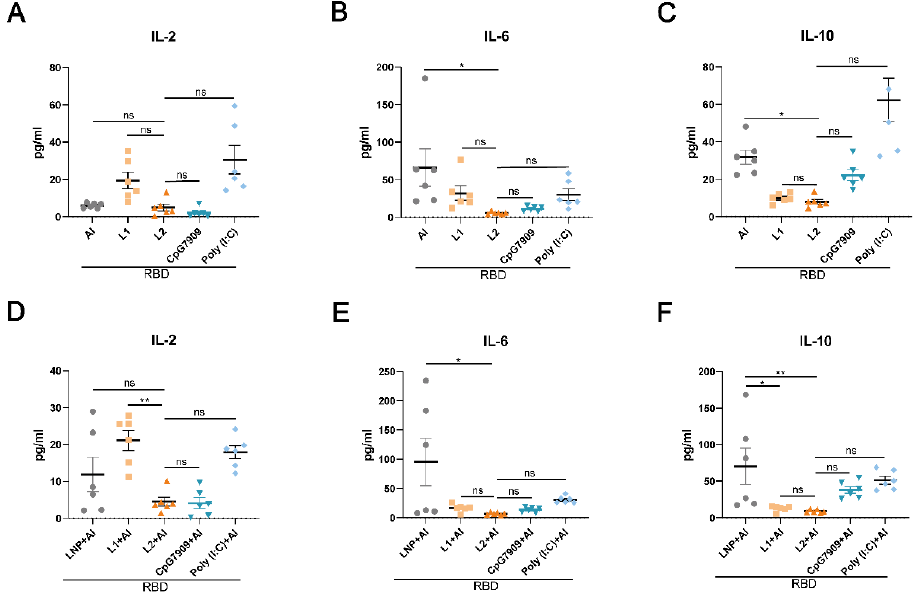
Figure Appendix A2. Levels of IL-2, IL-6, and IL-10 secreted by splenocytes in mice. ( A – C ) Levels of IL-2, IL-6, and IL-10 secreted by splenocytes in RBD + Al, RBD + L1, RBD + L2, RBD + CpG7909, and RBD + Poly(I:C). ( A ) IL-2. ( B ) IL-6. ( C ) IL-10. ( D – F ) Levels of IL-2, IL-6 and IL-10 secreted by splenocytes in RBD + LNP + Al, RBD + L1 + Al, RBD + L2 + Al, RBD + CpG7909 + Al, and RBD + Poly(I:C) + Al. ( D ) IL-2. ( E ) IL-6. ( F ) IL-10. * p < 0.05. ** p < 0.01. n = 6 for each